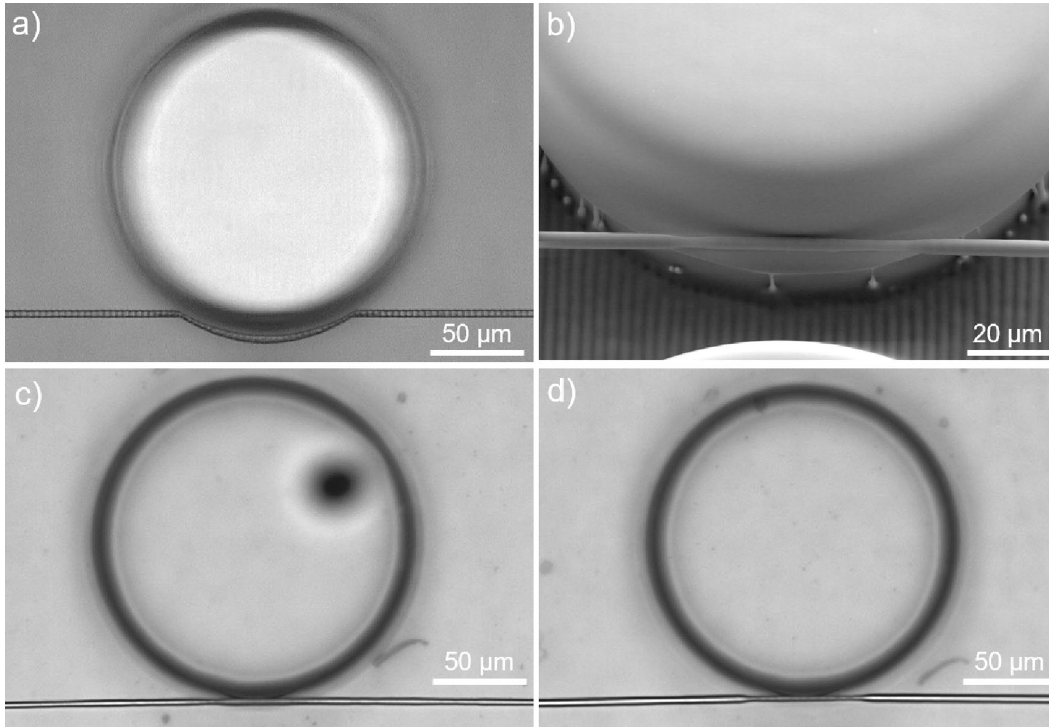
Figure 3. Writing technique of the suspended waveguide and morphing effect. ( a ) Top view image of the device before thermal annealing depicting the writing technique of the suspended waveguide. ( b ) SEM image of the device after annealing, where due to the morphing effect, the suspended waveguide is tangent to the microresonator. ( c , d ) Top view images of the device after thermal annealing, with a straight and tapered waveguide,